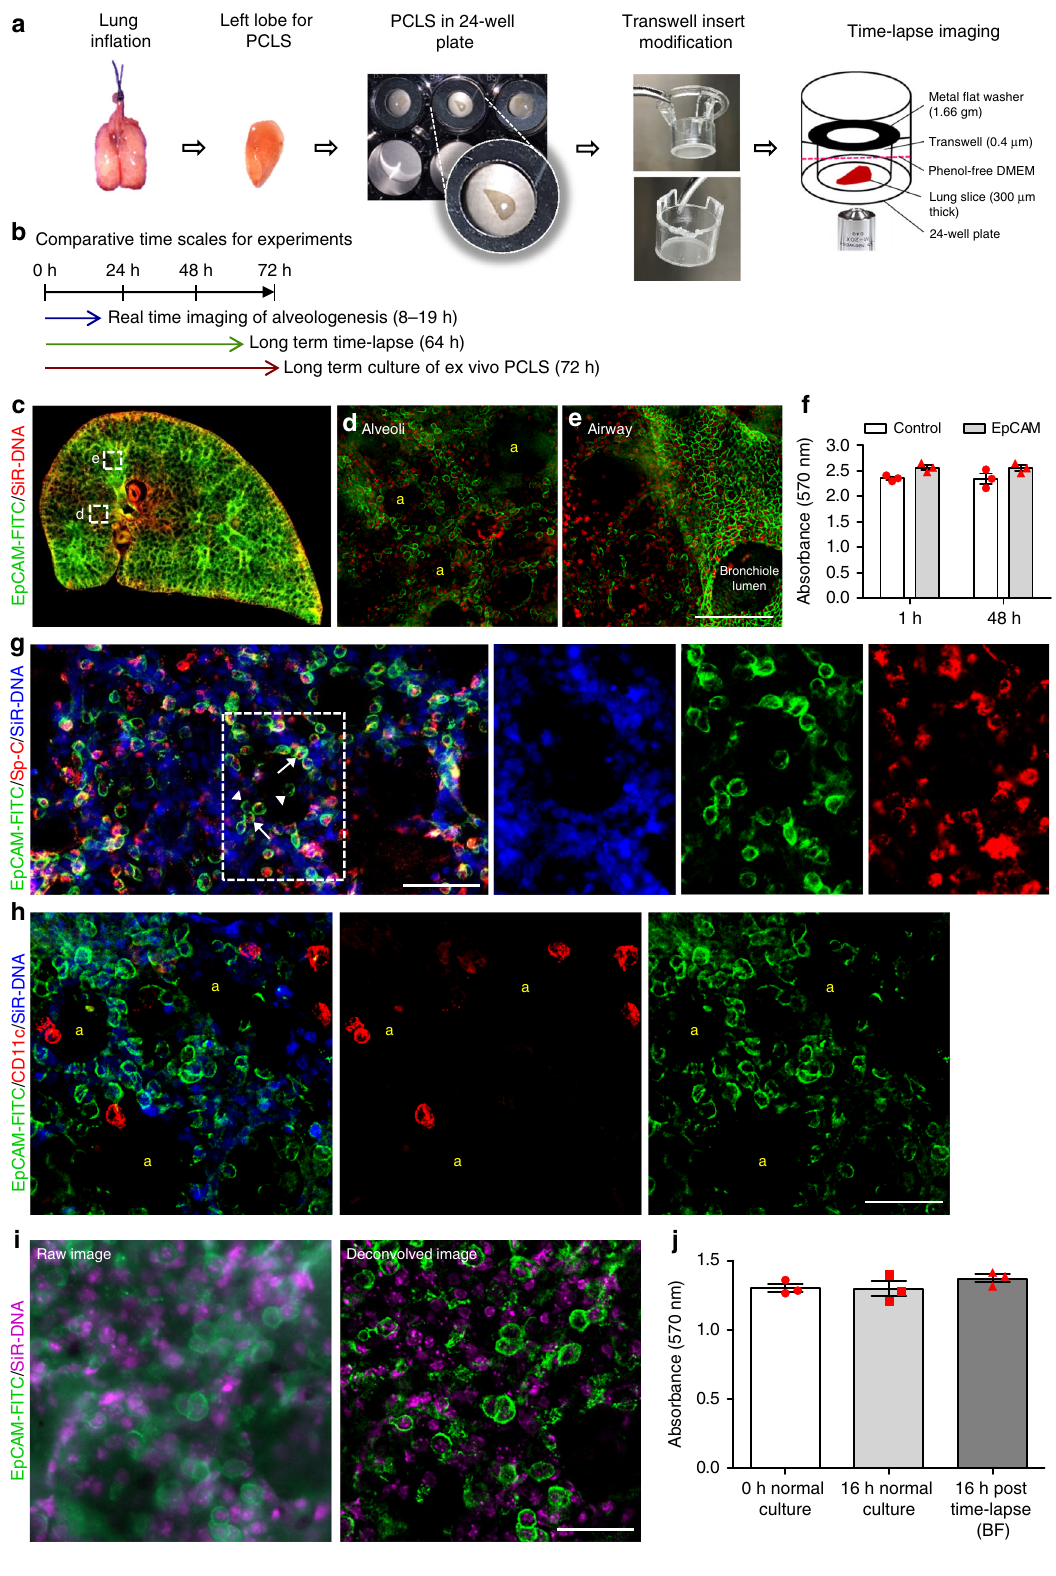
epithelial subtypes present e.g., ATI (Fig. 1g, arrowheads). Triple labelling with EpCAM-FITC, SiR-DNA and a live cell marker for macrophages, CD11c conjugated to PE (Phycoerythrin: CD11c- PE) showed there was no off-target uptake of EpCAM by macrophages (Fig. 1h; Supplementary Figure 1d). Labelling of